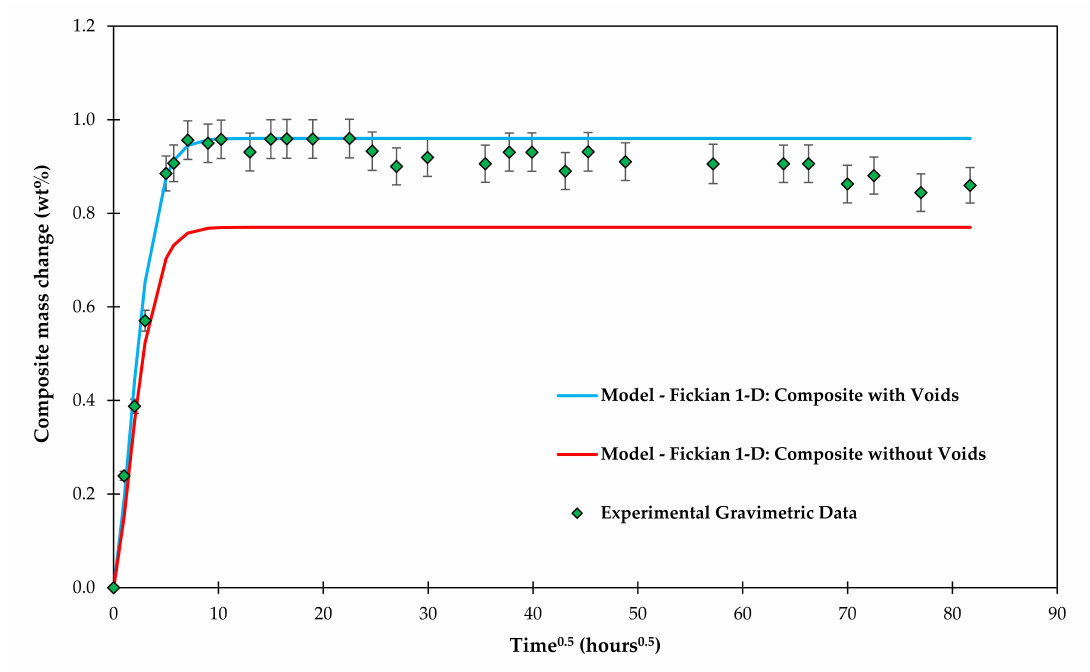
Figure 4. Experimental gravimetric measurements of composite C3 plates conditioned in water and modeled water uptake curves using the Fickian 1-D